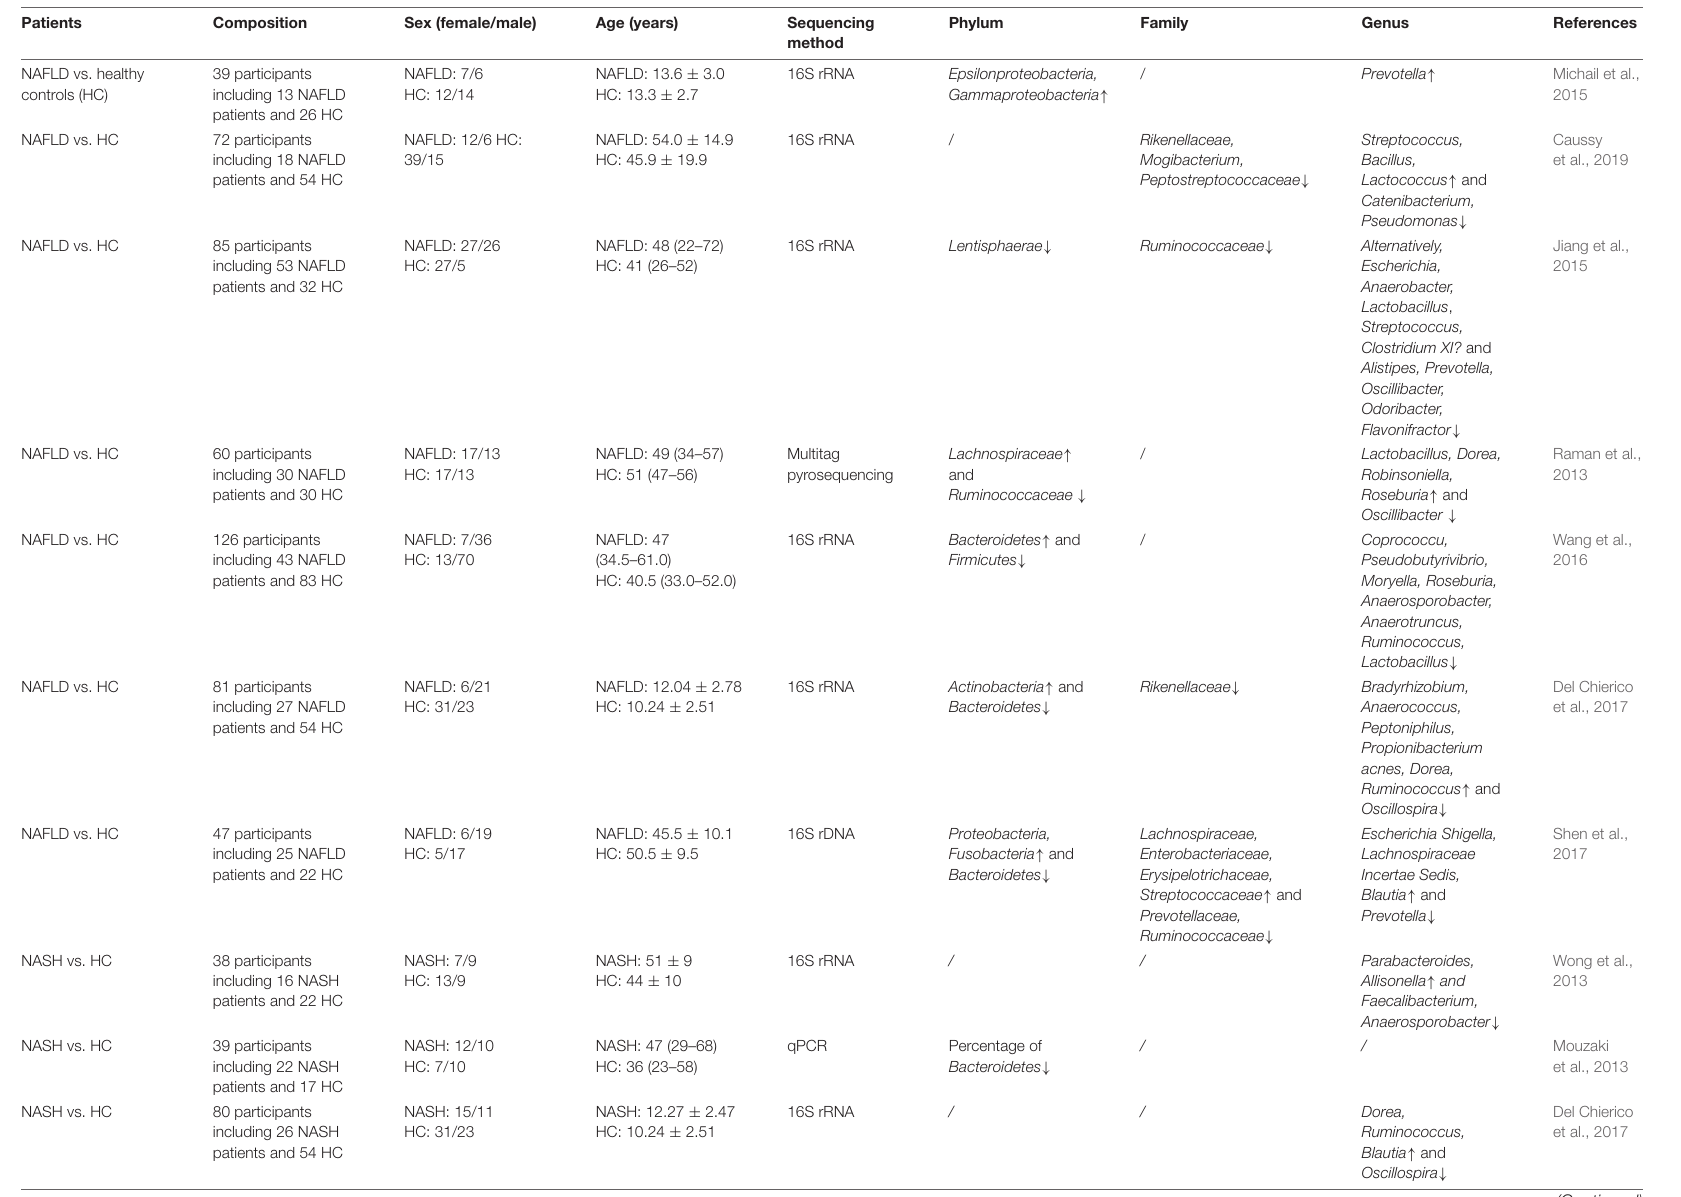
TABLE 1 | Differential gut microbiota between patients with different progression of non-alcoholic fatty liver disease. Patients